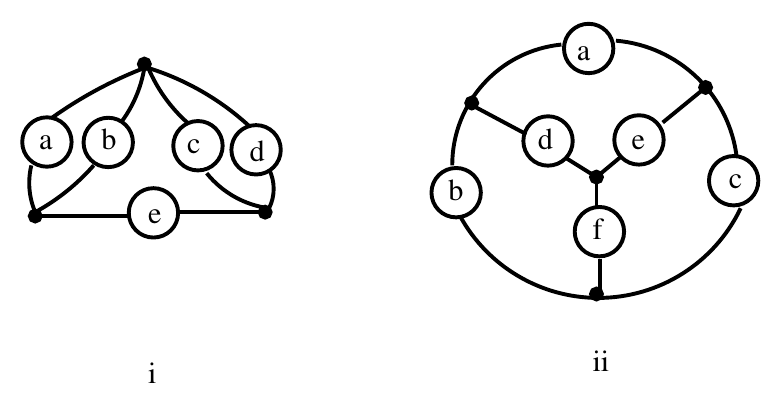
Figure 7 . The modular graphs (i) P a;b ; c;d ; e and (ii) M a;b;c;d;e;f .